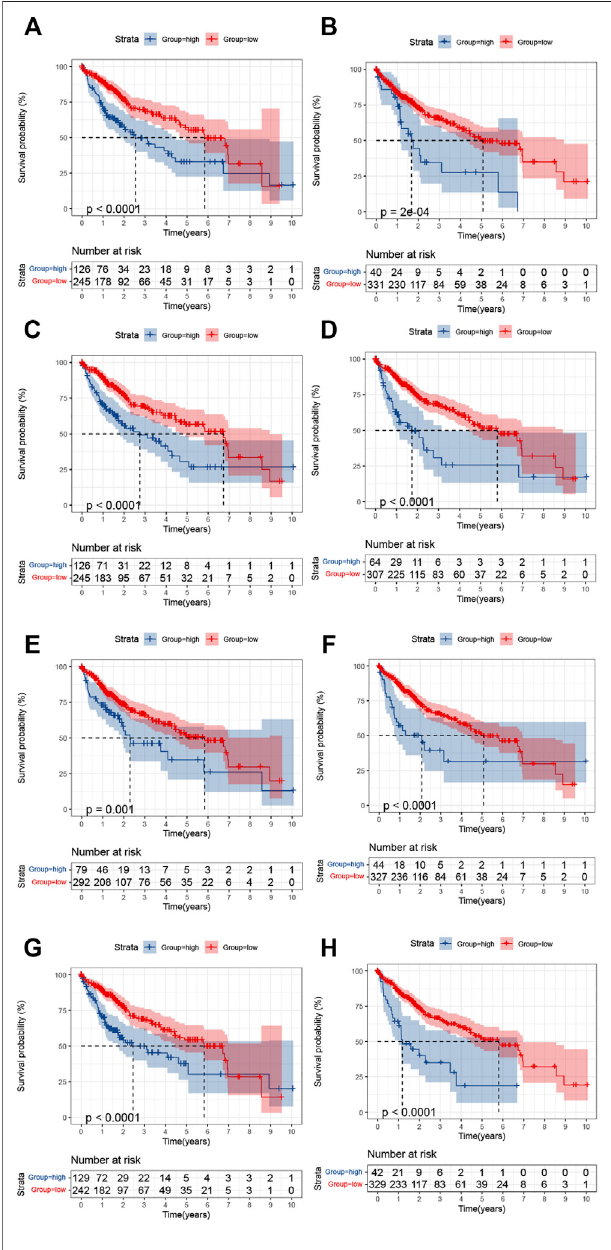
FIGURE 9 | Kaplan-Meier analysis of the survival in the high- and low- expression groups of the eight DENRGs. (A) CHST1 (B) BMP6 (C) TMCO3 (D) PFKFB4 (E) PAGE2 (F) SPESP1 (G) CTSV(CTSL2) (H) MCS-AS1.